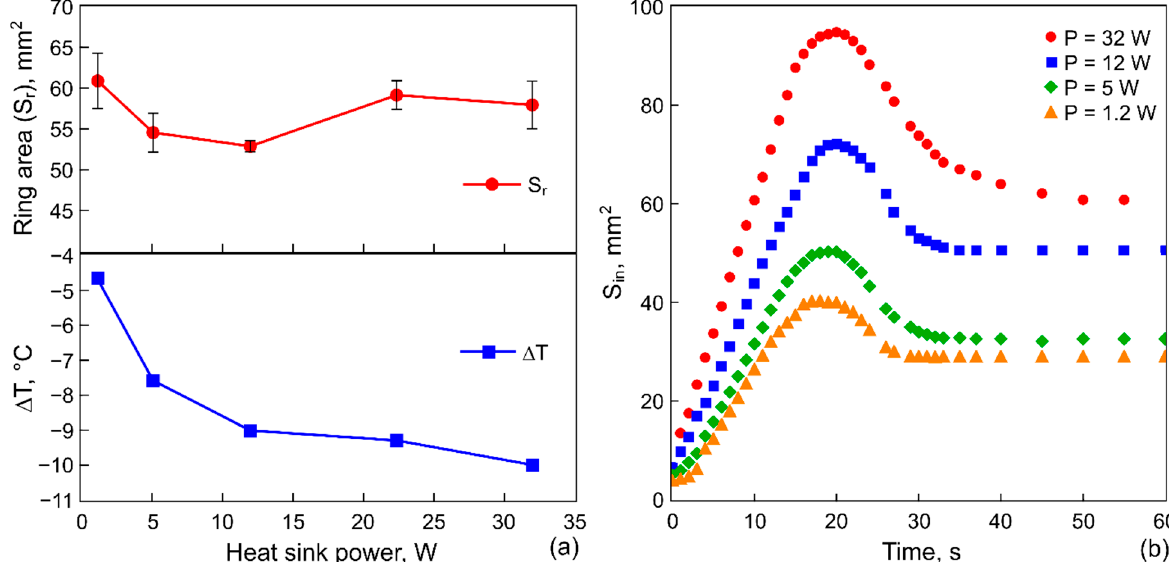
Figure 7. ( a ) Ring-deposit area and the temperature decrease on the rod, ∆ T = T ( τ ) − T 0 , versus the cooling power of the Peltier module, τ = 10 s. ( b ) Evolution of the inner area (the area cleared from particles) forming at different cooling powers of Peltier module: 1.2 W, 5 W, 12 W, and 32 W at 𝜏 = 10 s.